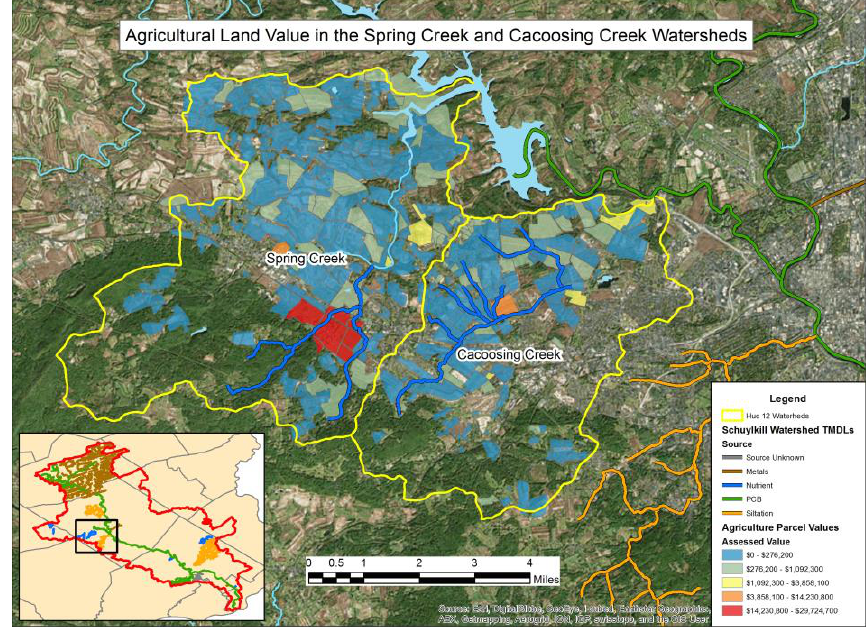
Figure 8. Map of land use, sub-watersheds, property values and impaired waterways.